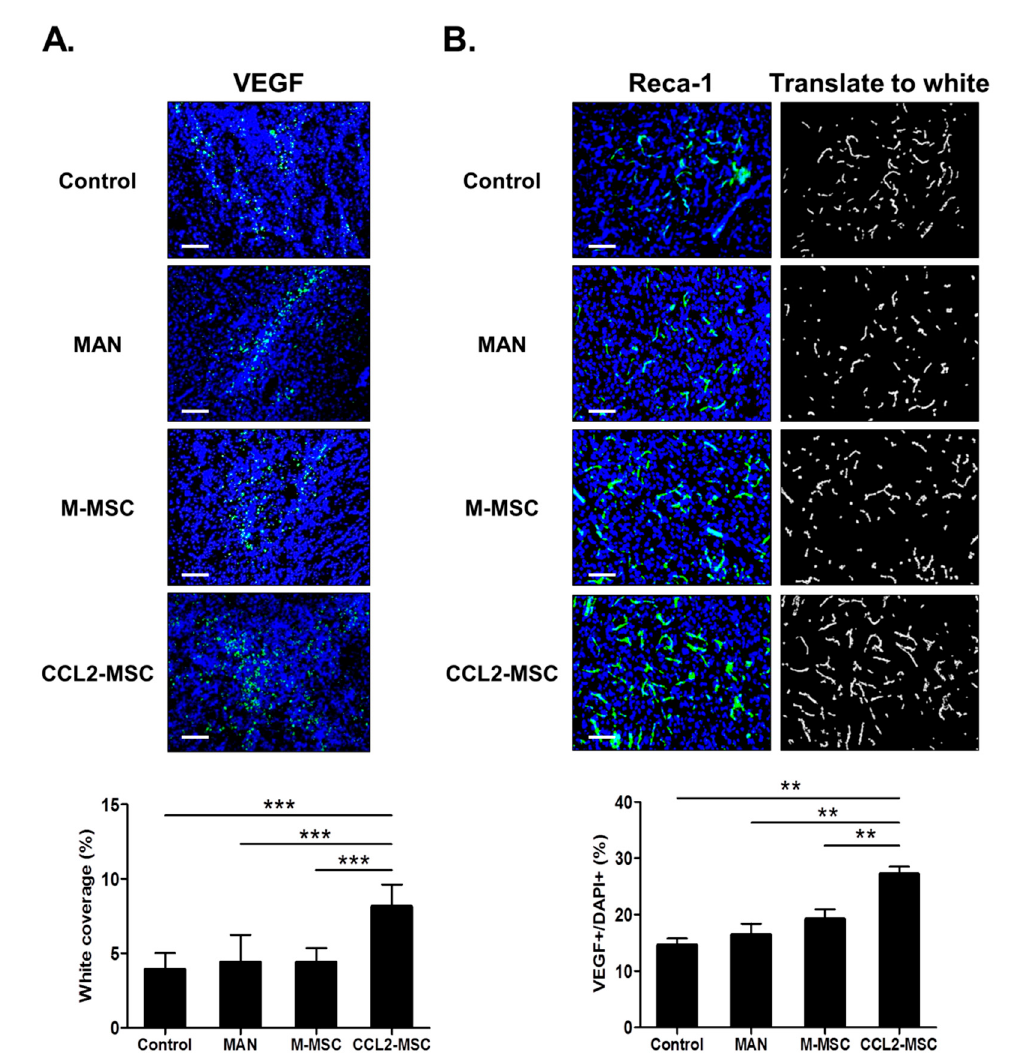
Figure 5. Changes in angiogenesis in the peri-infarct area following hUC-MSC transplantation. Immunostaining analyses were performed 28 days after MCAo induction. ( A ) Representative immunostaining images showing VEGF + cells in each group. The graph shows the number of VEGF + cells in each group. ( B ) Representative immunostaining image showing RECA-1 + vessels in each group. The graph shows vessel density in the peri-infarct area in each group. Data represent the mean ± SEM ( n = 5 / group) and were analyzed by one-way ANOVA. ** p < 0.01, *** p < 0.001. Scale bar = 100 µm.